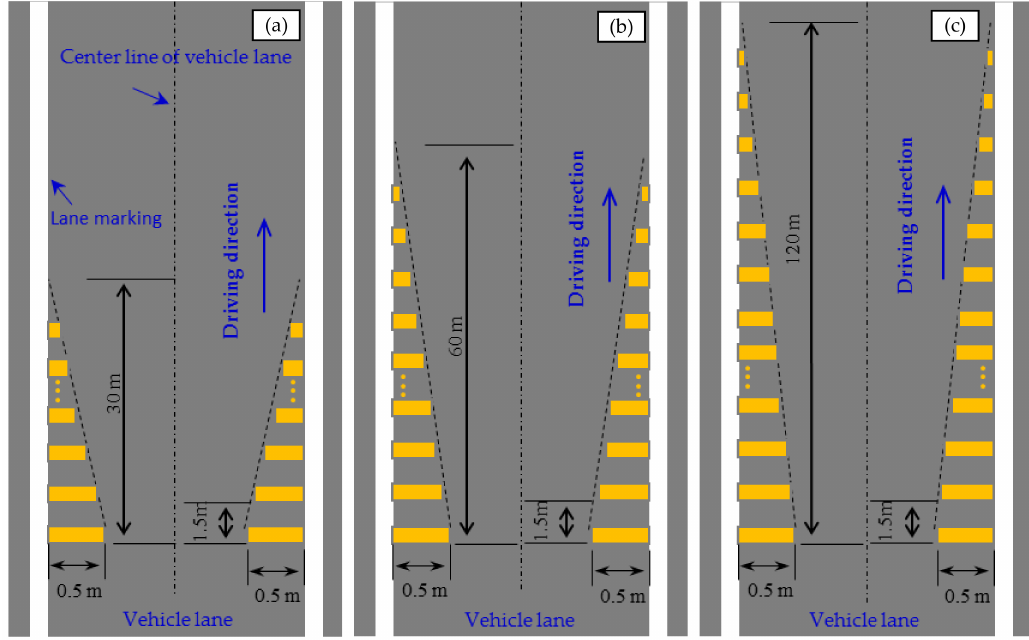
Figure 1. Design of reverse-perspective-illusion deceleration lines (RPIDLs) with different group lengths: ( a ) 30 m; ( b ) 60 m; ( c ) 120 m.